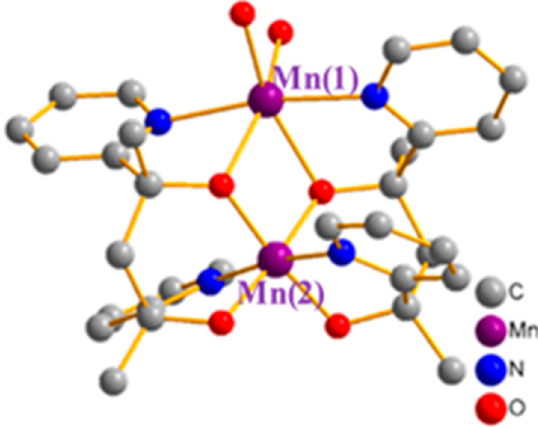
Table 3. Selected bond distances (Å) and angles (deg) of compound 2 .